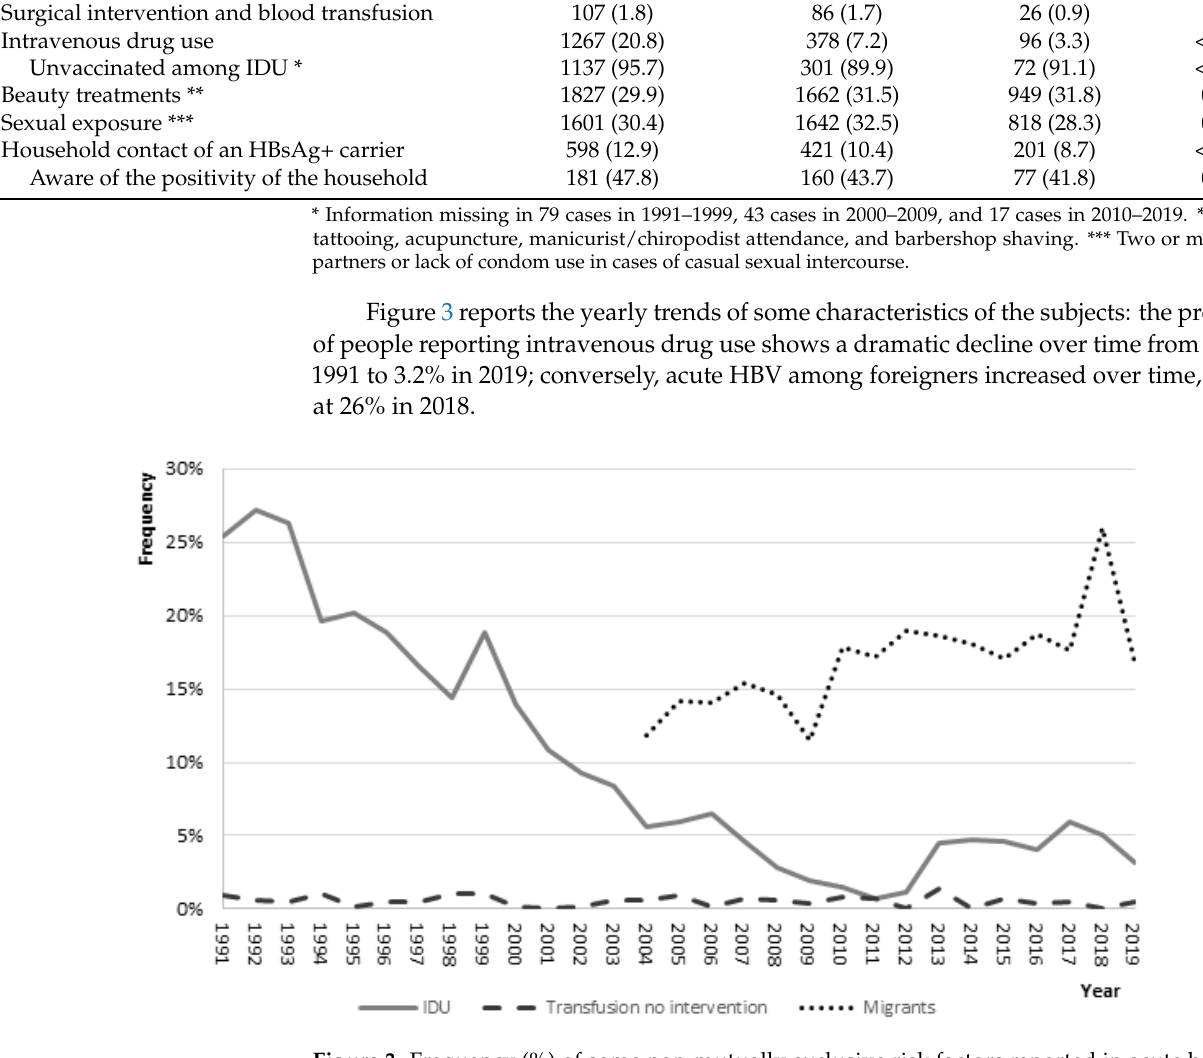
Table 3. Comparison of acute hepatitis B cases in Italy by area of birth. SEIEVA 2010–2019.